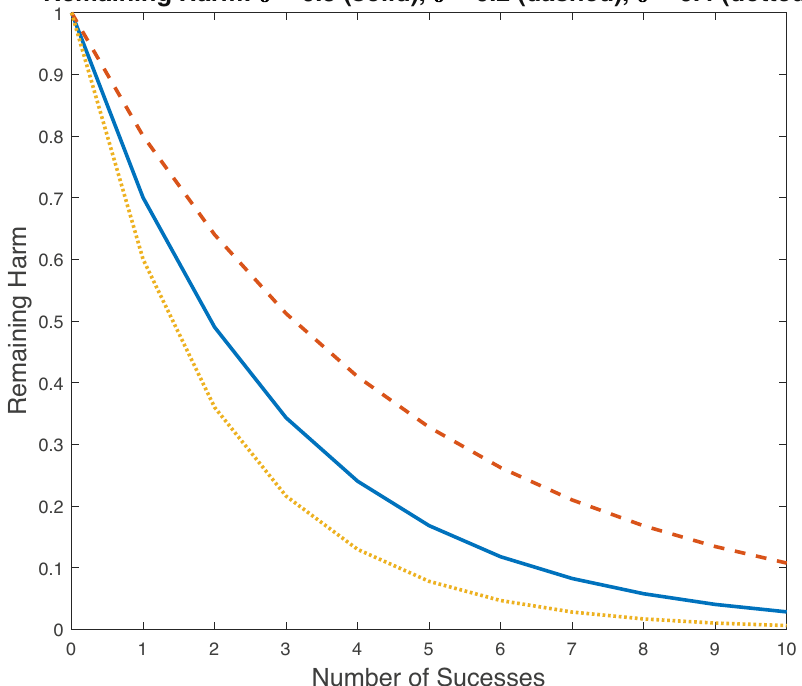
Fig. 3 Remaining Harm. This fi gure plots remaining harm versus the number of successes for varying assumption about ( δ ) the fraction of remaining harm each success